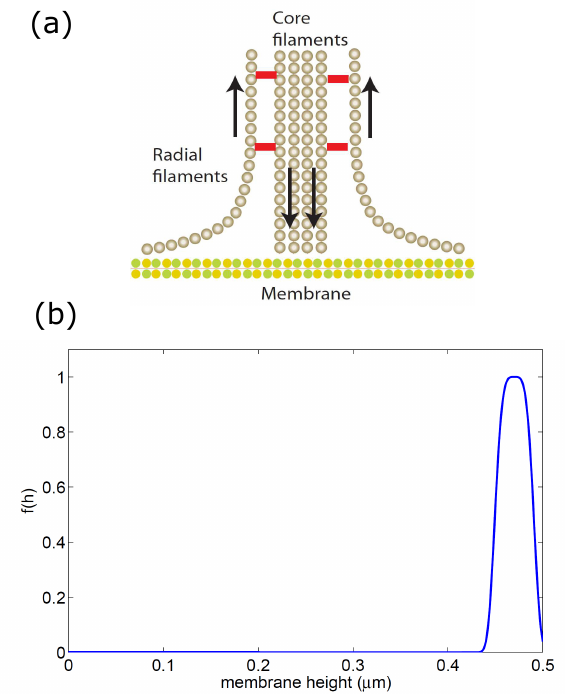
Figure 6. ( a ) Schematic illustration of the actin cables around the core of the podosome, where the treadmilling flow induces shearing and pulling forces near the membrane. These forces are thought to activate integrin-based cell adhesion [30]. ( b ) the function f ( h ) (Equation (4)) that we used to limit the binding of the adhesion proteins only to within a distance of 2 l 0 from the substrate (here h wall = 0.5 µ